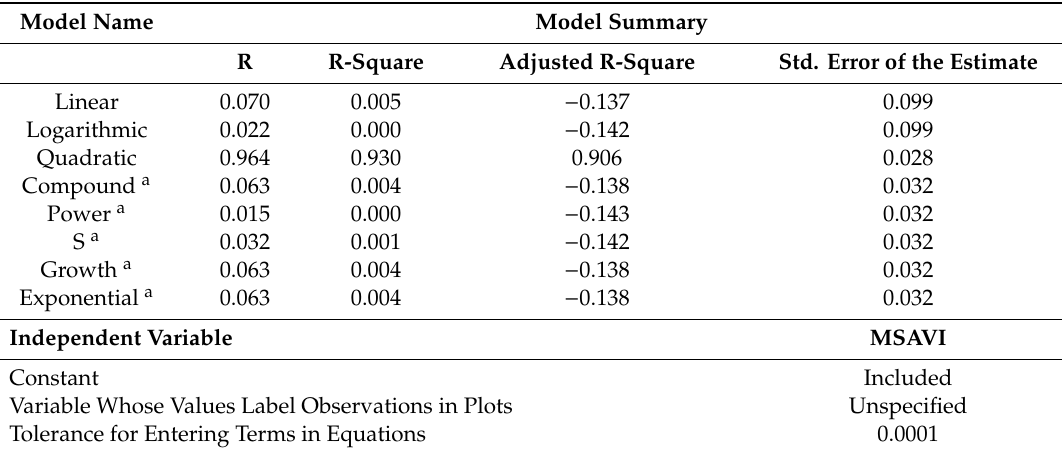
Figure 5. Summary of R-squares and root mean square errors (RMSEs) for each of the Vis (All abrevaitions are mentioned in Table 5). Table 8. Model summary of modified soil-adjusted vegetation index (MSAVI) in SPSS software.